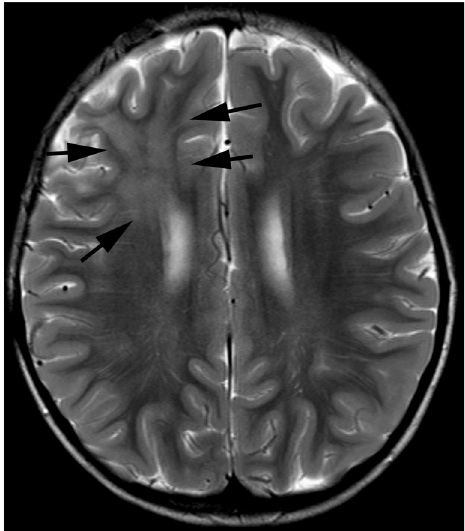
Fig. 11 Radiation induced white matter injury. A 5-year-old boy, who received radiation therapy for anaplastic ependymoma, was asymptomatic. A T2-weighted image shows hyperintensity in the right frontal lobe which was irradiated ( arrows